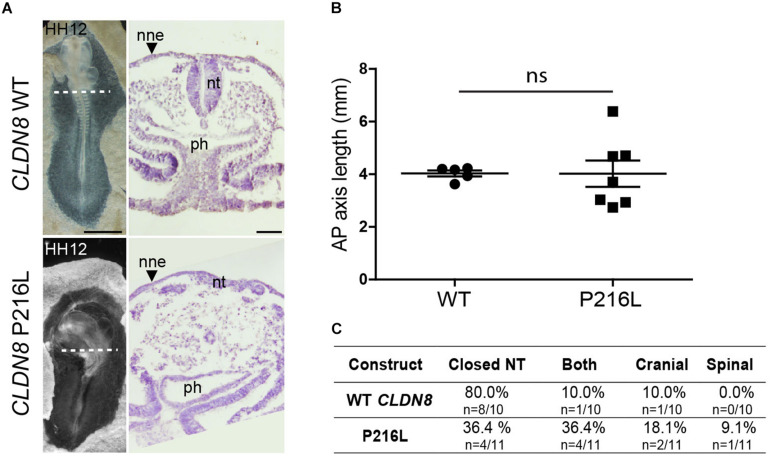
Embryos overexpressing CLDN8 P216L exhibit open NTDs due defective apical constriction. (A) Left, dorsal view of chick embryos electroporated with wild-type (WT) CLDN8 or CLDN8 P216L. Right, H&E staining of transverse sections of whole embryos at the level indicated by the dashed line. Scale bars, 1 mm (left) and 50 μm (right). (B) Graph shows anterior–posterior (AP) length of embryos electroporated with wild-type (WT) CLDN8 and CLDN8 P216L (mean ± s.e.m., ns, non-significant, Mann–Whitney U-test). (C) Table showing the distribution of complete, cranial and caudal open NTDs observed in embryos overexpressing wild-type CLDN8 or CLDN8 P216L. nne, non-neural ectoderm; nt, neural tube; ph, pharynx.